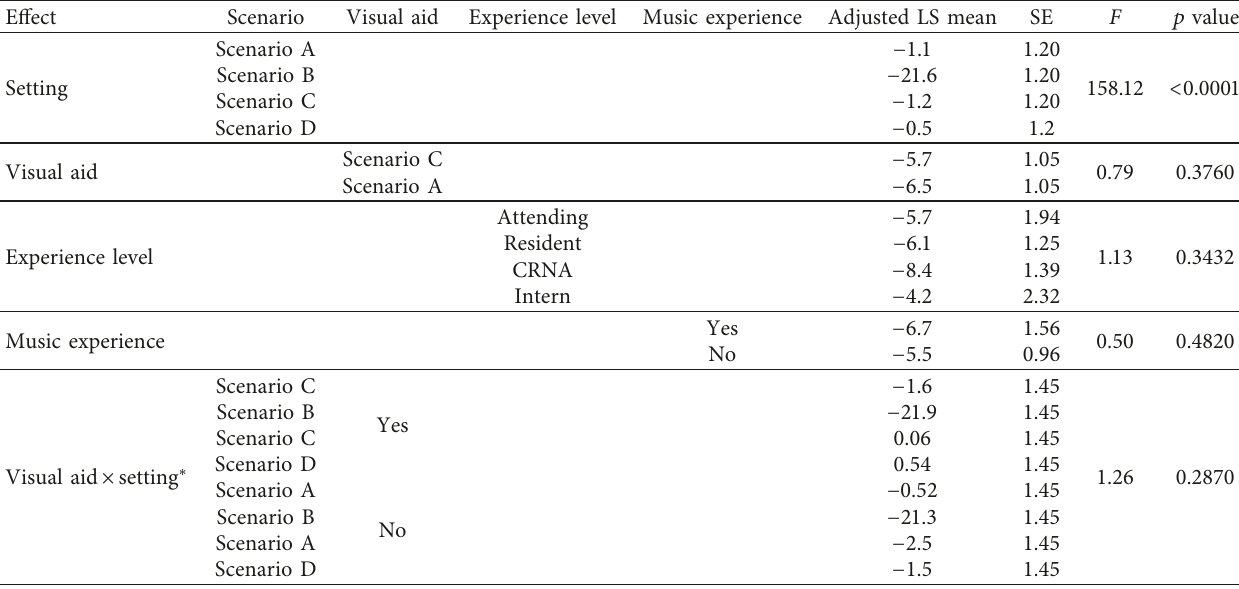
Table 3: Repeated measures mixed model results for recording setting, music, and training level on heart rate estimation accuracy.